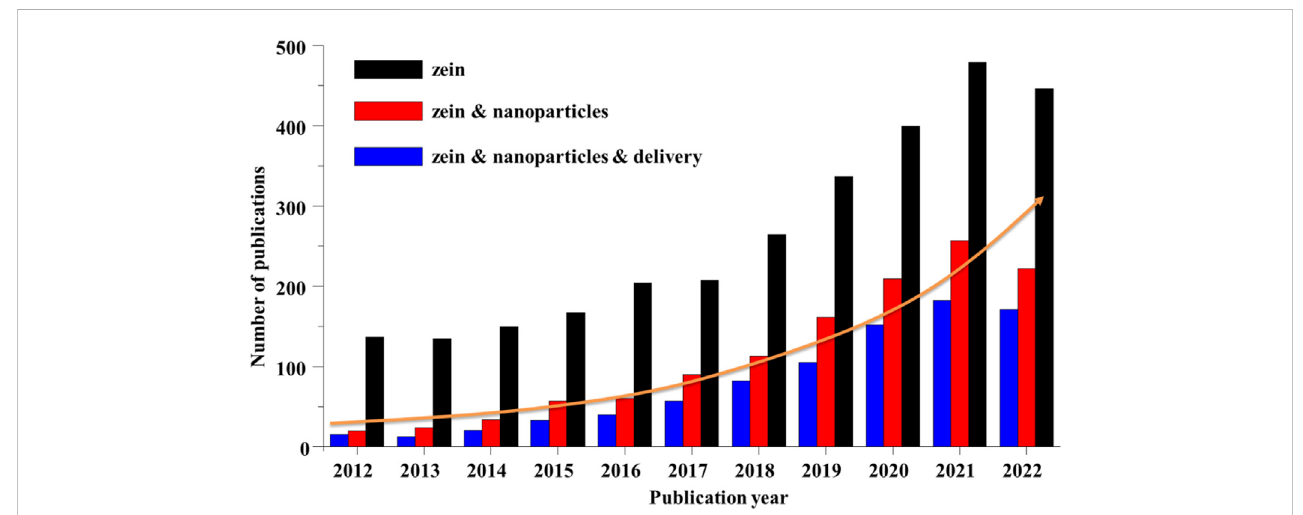
FIGURE 6 Numberofpublicationsonzein,zein&nanoparticles,zein&nanoparticles&deliveryduringtheyears2012 – 2022.Allthedatawereobtainedthroughthe Web of Science system as of 12 January